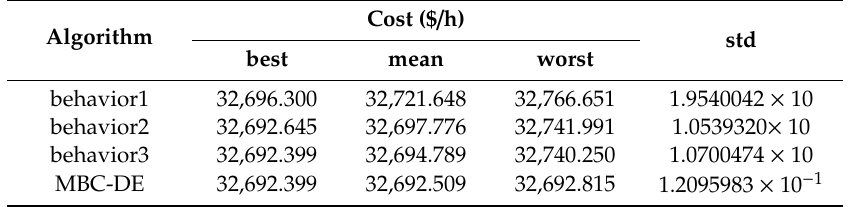
Table 9. Algorithms comparison between multi-behavior and single-behavior for test case 2.